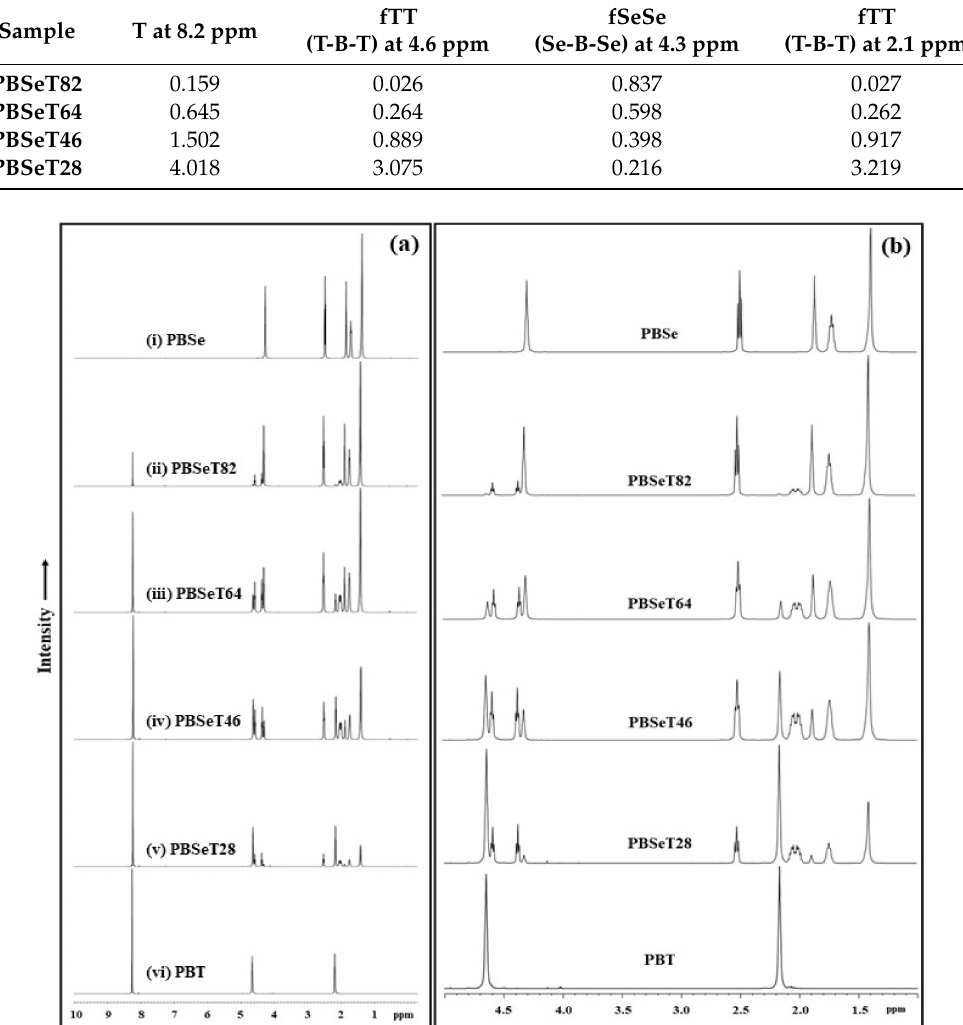
Table 2. Integration value of comonomer of copolyesters with various content of aromatic units.